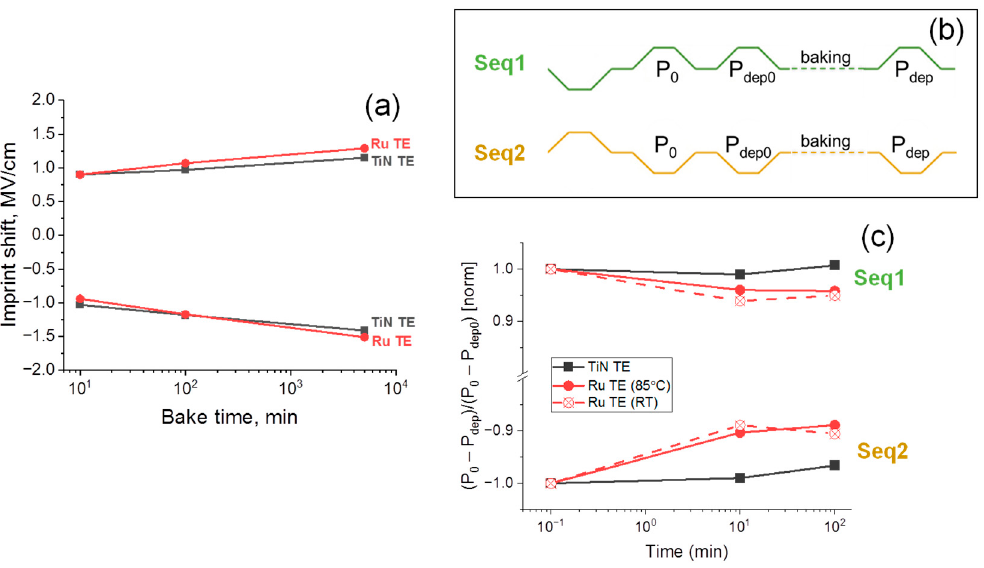
Figure 7. ( a ) Imprint shift estimated from the dynamic I sw -E curves; ( b ) the waveforms applied for measurements of depolarization-related loss of 2P r ; ( c ) results of the depolarization-related loss of 2P r measurements performed after different times of storage at 85 °C (solid lines) and at RT (dotted lines) from the device with TiN TE (black lines) and Ru TE (red lines). Lines serve as a guide for the eye.